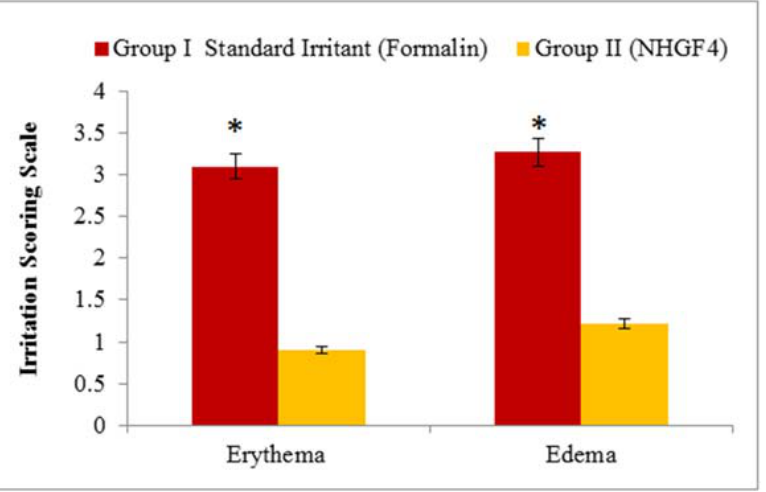
Figure 8. Skin irritation studies: erythema and edema. Data expressed as mean ± SD; n = 3. One-way ANOVA followed by post hoc Tukey test; * p < 0.05).